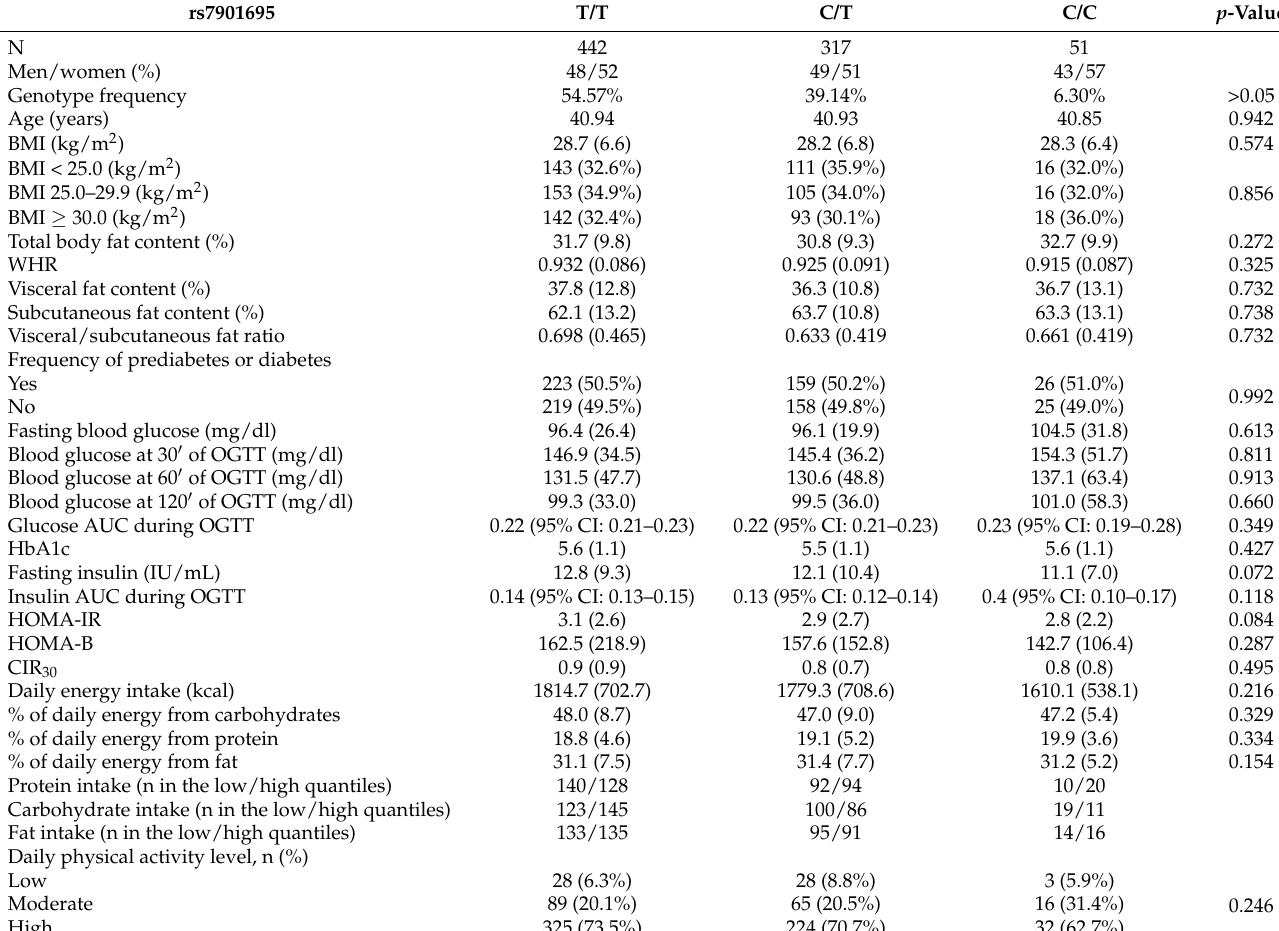
Table 1. Characteristics of participants stratified by rs7901695